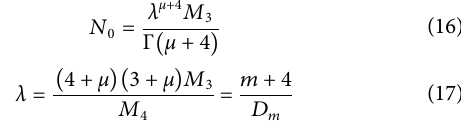
FIGURE 1 Simulation setting (A) Guyuan City (B) Jingyuan County (C) Longde County (D) Xiji County (E) Haiyuan County (F) Zhongwei City, the blue area is the area affected by the